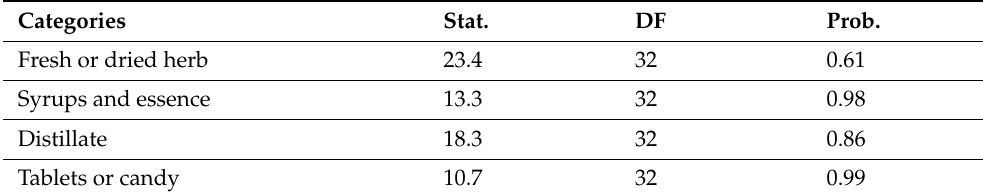
Table 5. The results of Hausman test for IIA